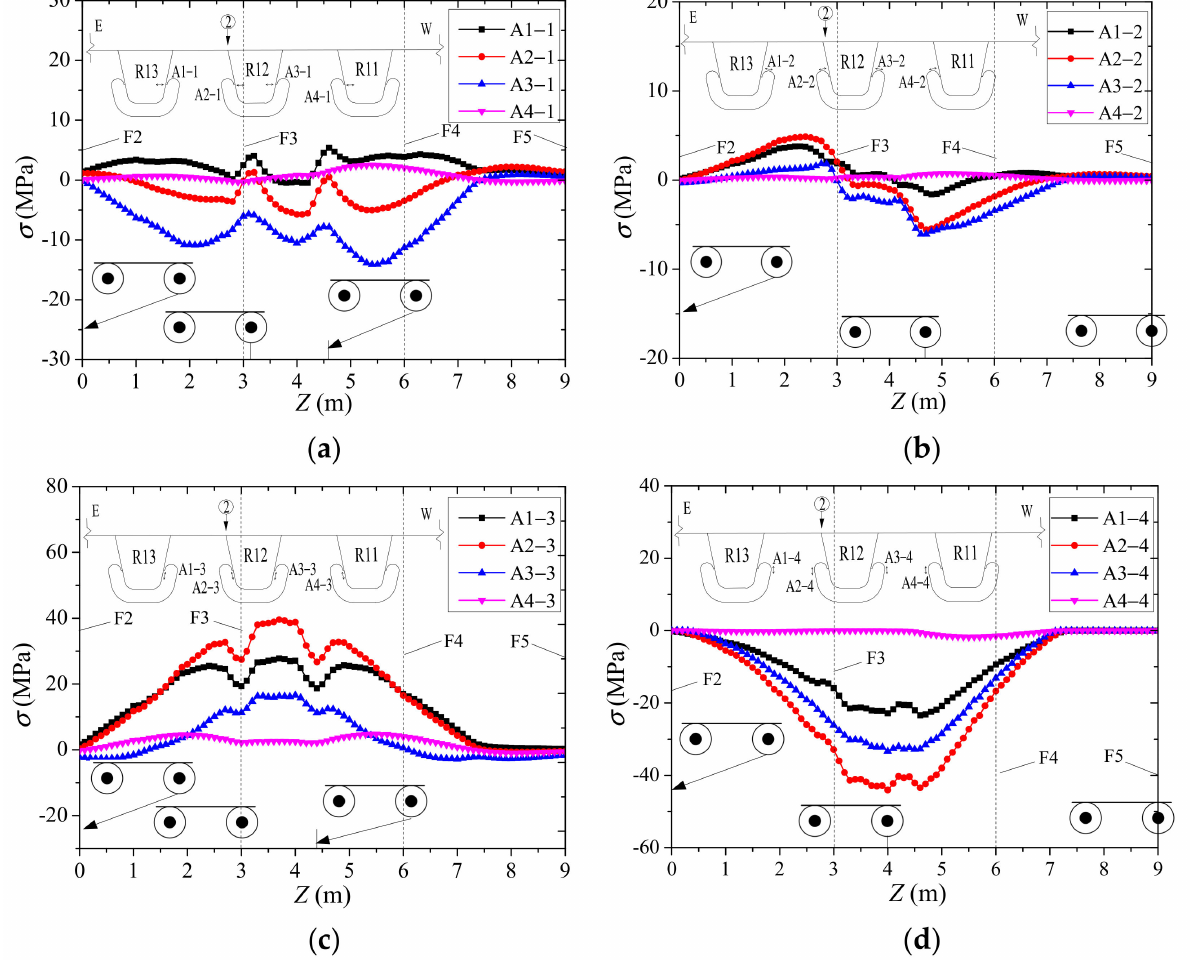
Figure 17. Calculated stress of the four details under LC2. ( a ) RF-R; ( b ) RF-F; ( c ) RF-W; ( d )